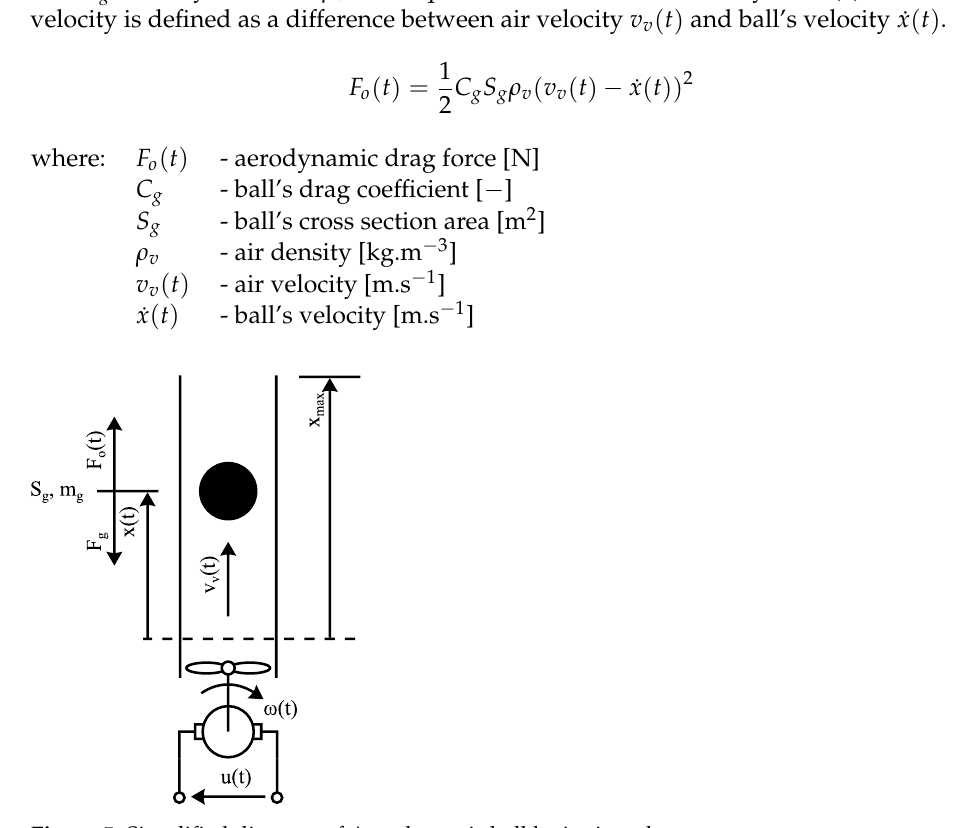
Figure 5. Simplified diagram of Aerodynamic ball levitation